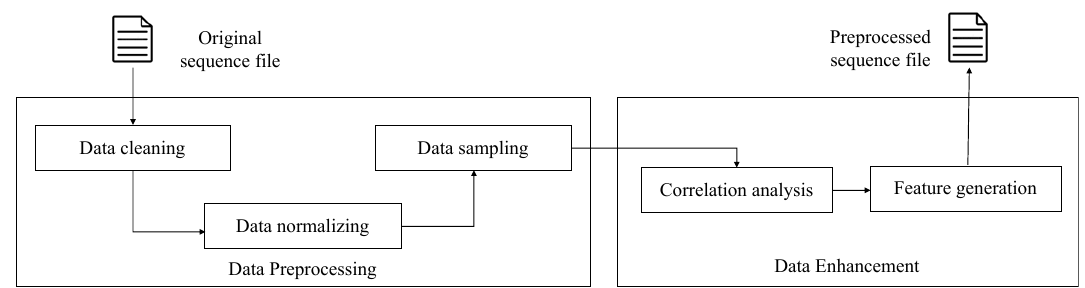
Figure 5. The diagram illustrating the process of data